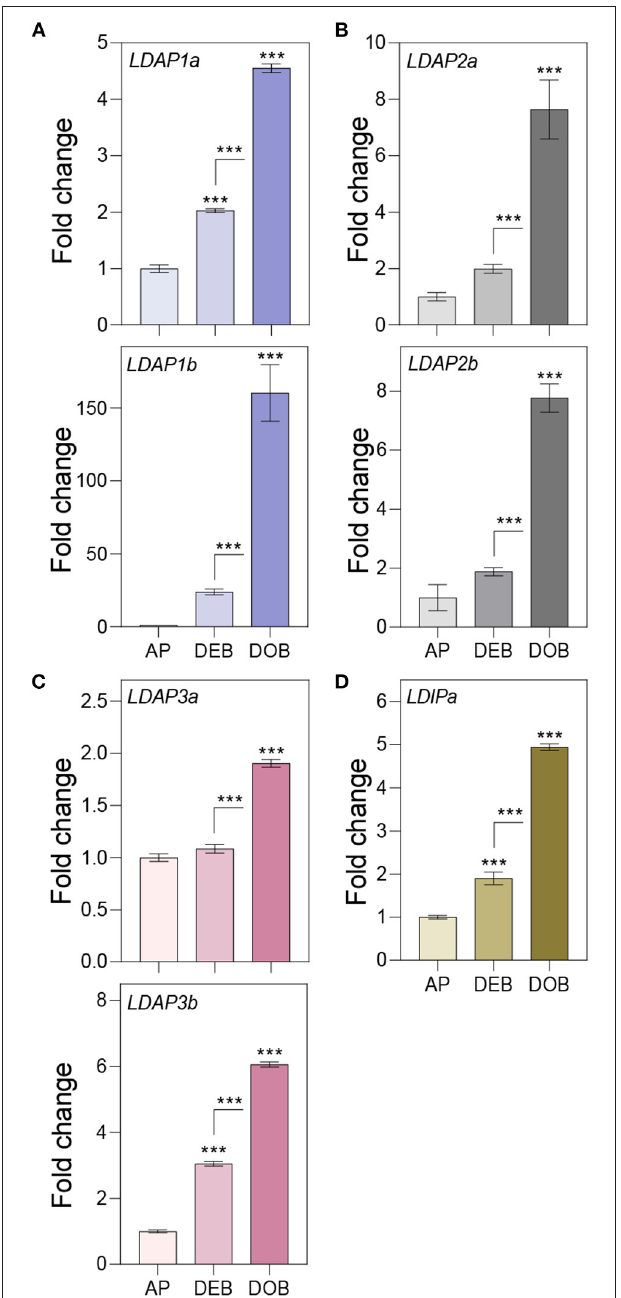
FIGURE 5 | Expression of genes associating with the lipid body monolayer. Relative expression of genes encoding for (A–C) LDAPs and (D) LDIP in apices (APs) under a long day, and in developing buds (DEBs) and dormant buds (DOBs) in short days. Values are calculated relative to the control (AP) and represent the means of three technical replicates ± SD of four plants. Asterisk(s) indicate statistical significance between treatments (one-way ANOVA, Tukey analysis; *** P < 0.001).